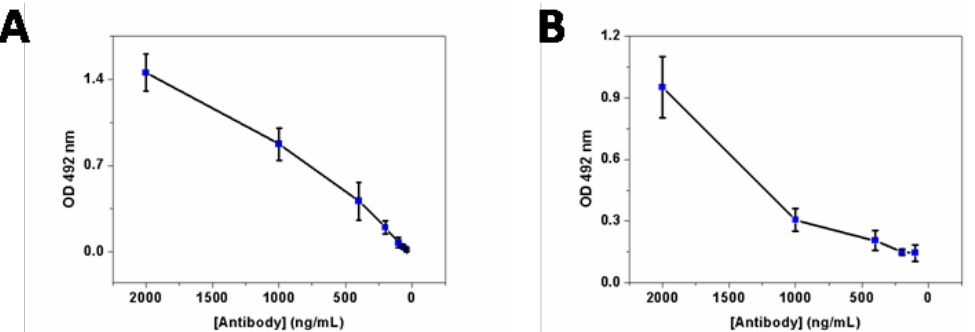
Figure 2. ( A ) Detection of the purified recombinant F17A by ELISA with the developed polyclonal antibody, decreasing concentration of the FPLC purified polyclonal antibody was used to detect the purified F17A protein-coated ELISA plate wells (100 µL of 5 µg·mL −1 solution in PBS). Detection limit was about 100 ng·mL −1 of purified rabbit antibody. ( B ) Detection of the native F17A at the surface of F17 fimbriae expressing E. coli strain. Each plate well was coated with 10 6 cells and polyclonal antibody was used to detect native F17A on the cell surface. Detection limit is about 200 ng·mL −1 .